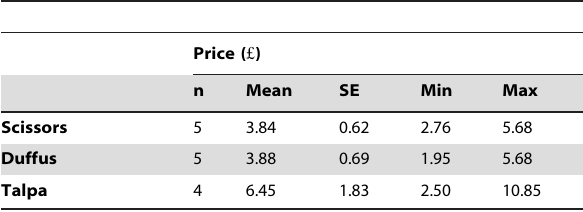
Table 6. Mean, standard error, minimum and maximum prices paid for mole trap